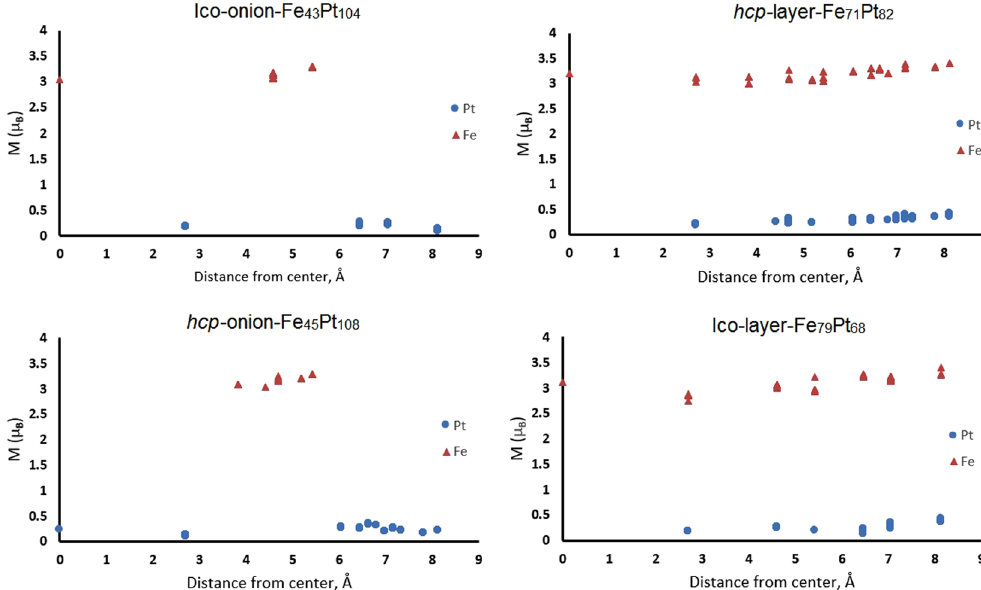
Figure 3. Magnetic moments of Fe and Pt atoms for some studied FePt NPs (icosahedral “onion-like” Fe 43 Pt 104 NP, icosahedral layered Fe